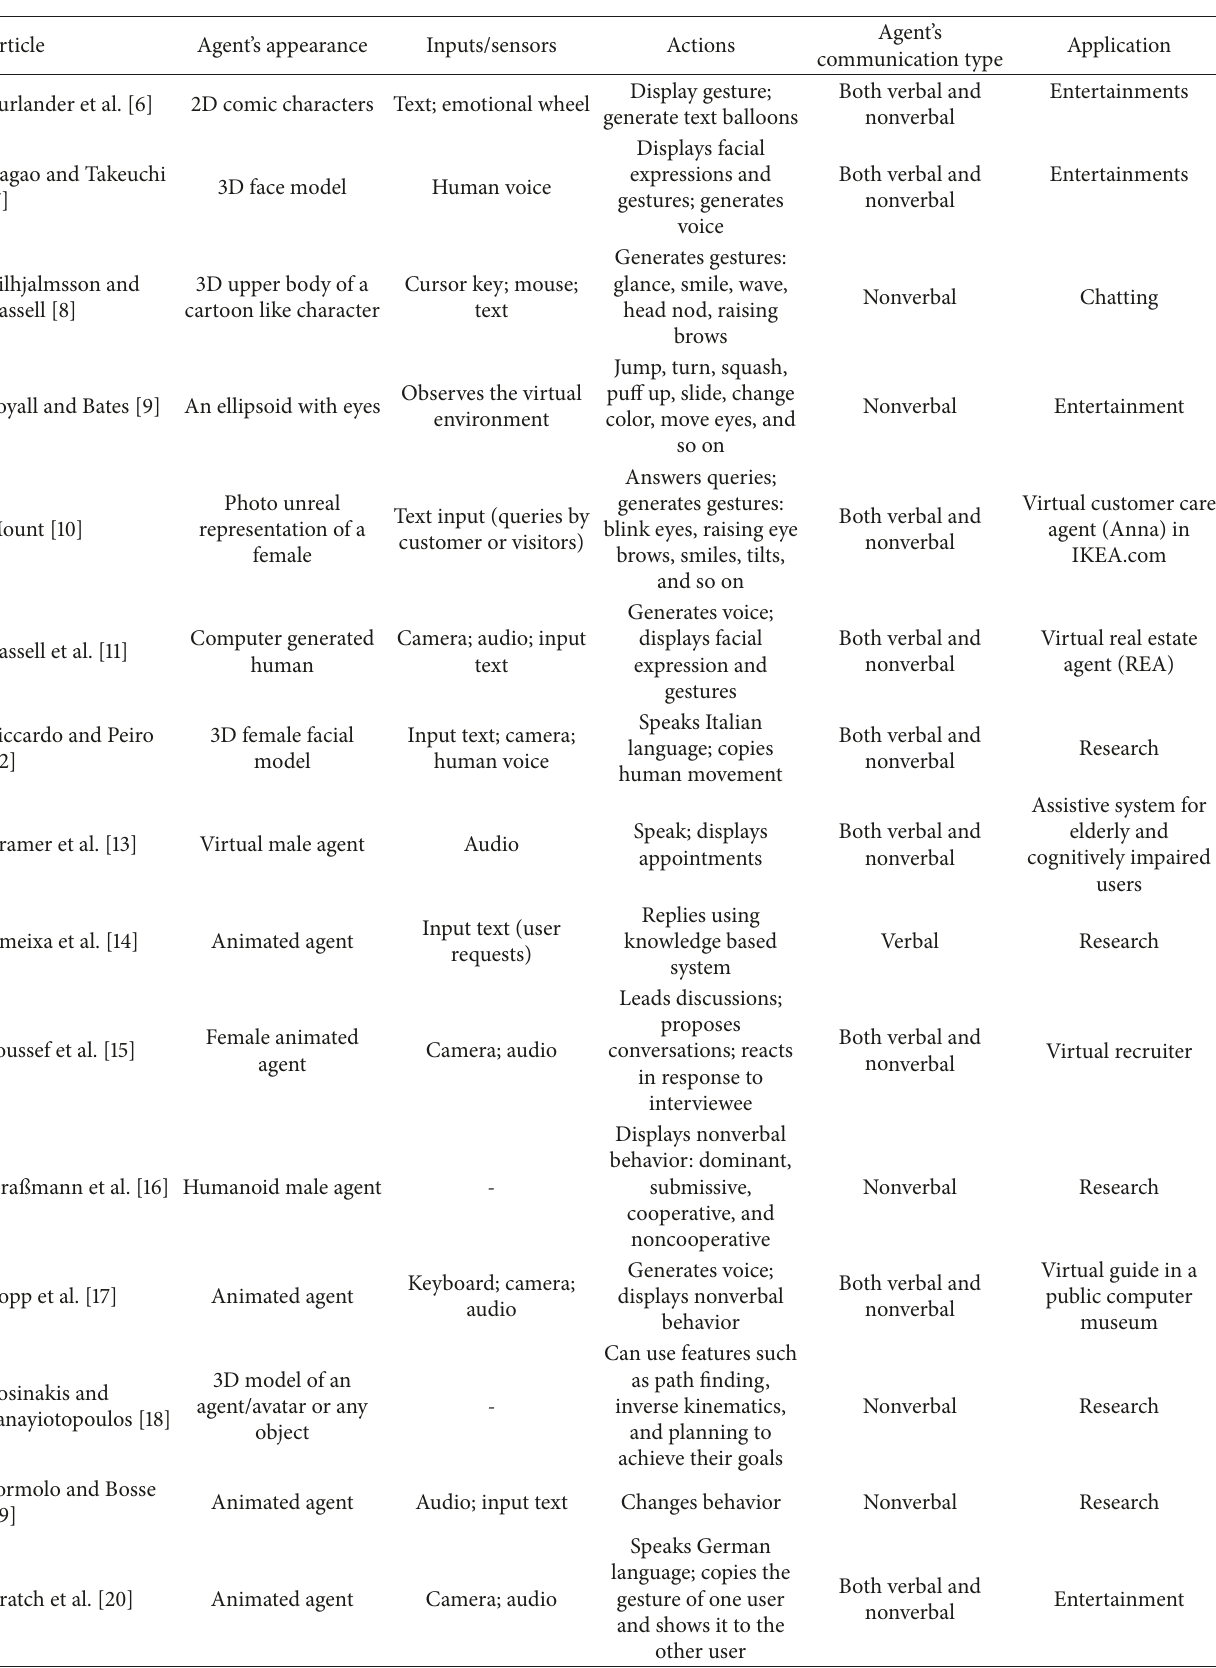
Table 1: Summarized related works in the